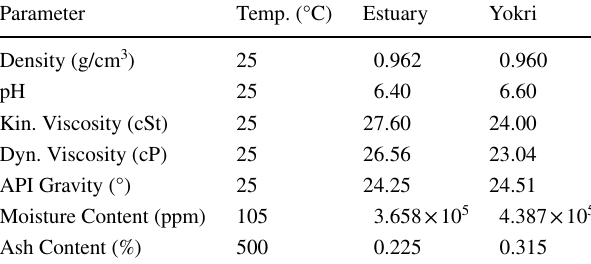
Table 1 Physicochemical characterisation of the crude oils